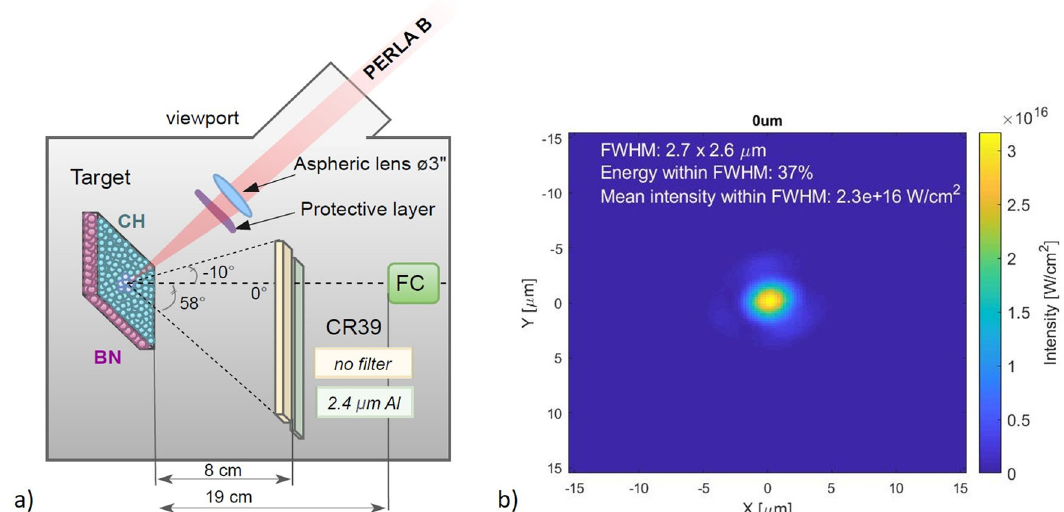
Fig. 1 Schematic of the experimental setup and laser focal spot pro fi le measurement. a Experimental setup inside the vacuum chamber: the laser pulse is incident on the CH-BN target (containing protons and Boron) at 45° through a viewport and is focused by an aspheric lens located inside the chamber. The lens is protected from debris by a transparent protective glass. Two CR39 stripes with plain and fi ltered regions are aligned in front of the target, leaving the equatorial plane unobstructed for the FC (Faraday Cup) placed at the target normal. b Post-processed photo of the spatial-intensity pro fi le of the laser focal spot measured on target. The FWHM (full width at half maximum) size of the focal spot along with the laser energy and mean intensity encircled inside it are stated in the fi gure.